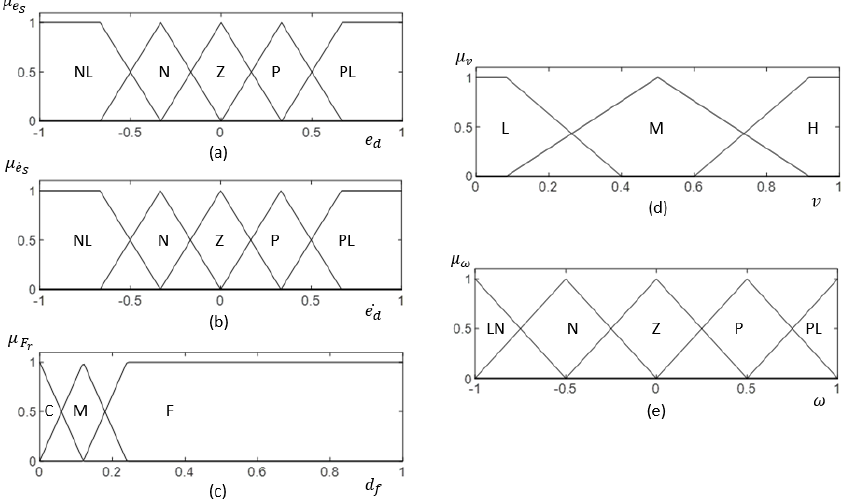
Figure 8. ( a – c ) represent the input membership function for e S , ˙ e S , and F r , respectively. ( d , e )